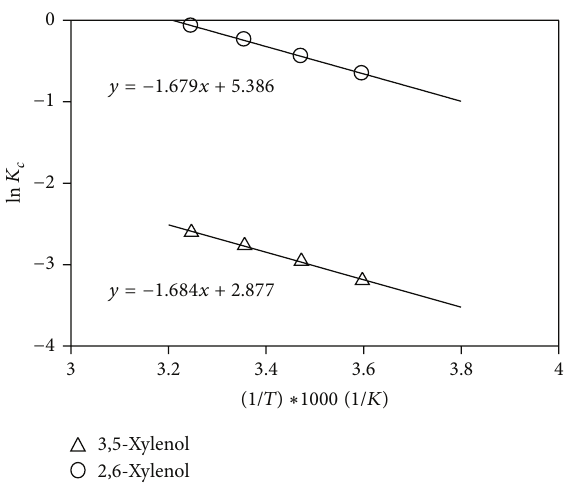
Figure 6: Effect of pH on the adsorption of 3,5-xylenol onto asphaltene.